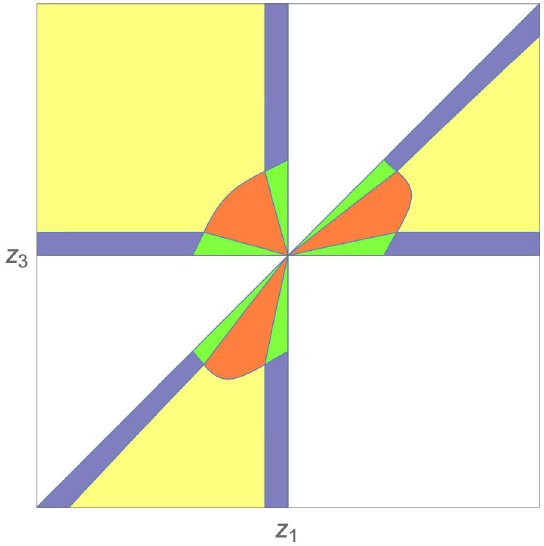
Figure 6 . The regions of moduli space of the C-O-O-O amplitude (with a fixed cyclic ordering) corresponding to the four Feynman diagrams in figure 5. For this figure, we have set the location of the second puncture z 2 (cid:16) 0 . The green region corresponds to figure 5(a), the red region to figure 5(b), the blue region to figure 5(c), and the bulk of the moduli space, shown in yellow, corresponds to figure 5(d). The chosen cyclic ordering p z 1 , 0 , z 3 q gives rise to three linear orderings, namely, z 1 ⁄ 0 ⁄ z 3 , 0 ⁄ z 3 ⁄ z 1 and z 3 ⁄ z 1 ⁄ 0 , which can be clearly identified. The same color is used to label different regions of the moduli space related by cyclic permutation of external open string